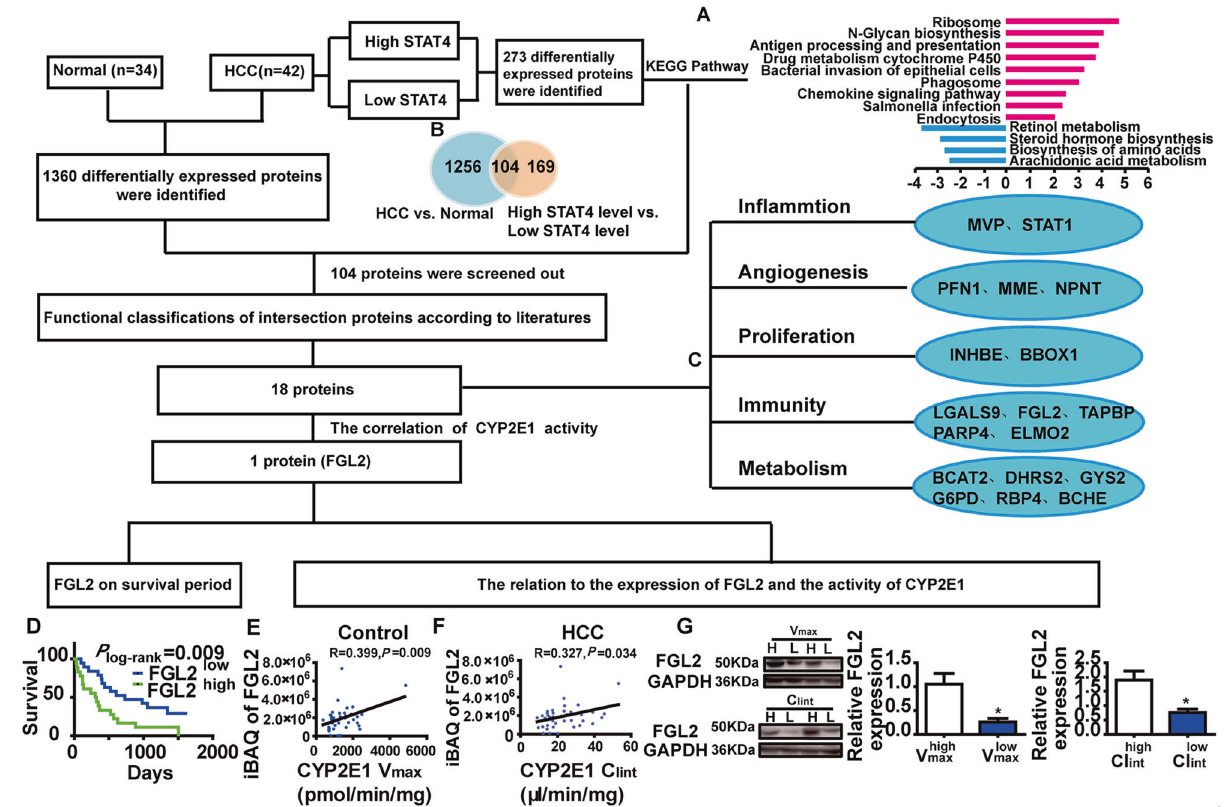
Fig. 3 Schematic diagram to identify differentially expressed proteins resulting from the stat4 polymorphism: possible regulation of the CYP2E1/FGL2 pathway. A An enrichment analysis of the KEGG pathway for differentially expressed proteins in hepato fi brotic tissue of HCC patients. B Venn diagram showing the number of differential proteins in hepato fi brotic tissue of HCC patients. C Functional classi fi cation of differentially expressed proteins affected by the STAT4 expression and HCC: in fl ammation, angiogenesis, proliferation, immunity, and metabolism. In fl ammation: MVP Major vault protein, STAT1 Signal transducer and activator of transcription 1. Angiogenesis: PFN Pro fi lin-1, MME Neprilysin, NPNT Nephronectin. Proliferation: INHBE Inhibin beta E chain, BBOX1 Gamma-butyrobetaine hydroxylase1. Immunity: LGALS9 Galectin-9, FGL2 Fibroleukin (Fibrinogen-like protein 2), TAPBP Tapasin (TAP-binding protein); PARP4-Poly [ADP-ribose] polymerase 4; ELMO2 Engulfment and cell motility protein 2. Metabolism: BCAT2 Branched-chain amino acid aminotransferase, DHRS2 Dehydrogenase/reductase SDR family member 2; GYS2 Glycogen synthase, G6PD Glucose-6-phosphate 1-dehydrogenase, RBP4 Retinol binding protein 4, BCHE Choline- esterase. D Kaplan – Meier curve of overall survival for patients grouped by median of FGL2 expression levels, P -values are depicted by Cox – Mantel log-rank test. E , F The correlation between the expression of FGL2 and the activity of CYP2E1 ( V max and Cl int ) in human HCC liver tissue, R and P -values by Pearson ’ s correlation test are depicted. G The expression of FGL2 on the median of V max and Cl int as the cutoff point, in HCC liver tissue by Western blot. GAPDH in each lane served as an internal control for normalization ( N = 3), *P < 0.05 was assessed by Student ’ s t -test.